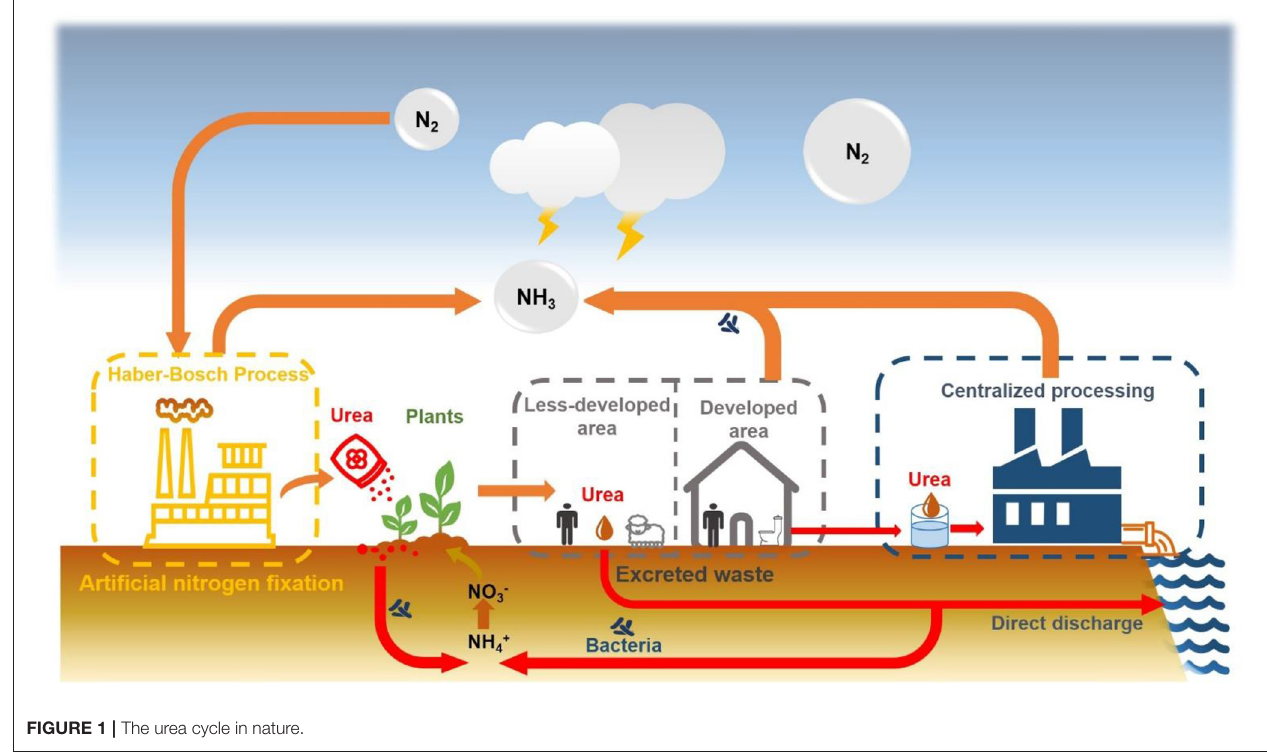
FIGURE 1 | The urea cycle in nature.